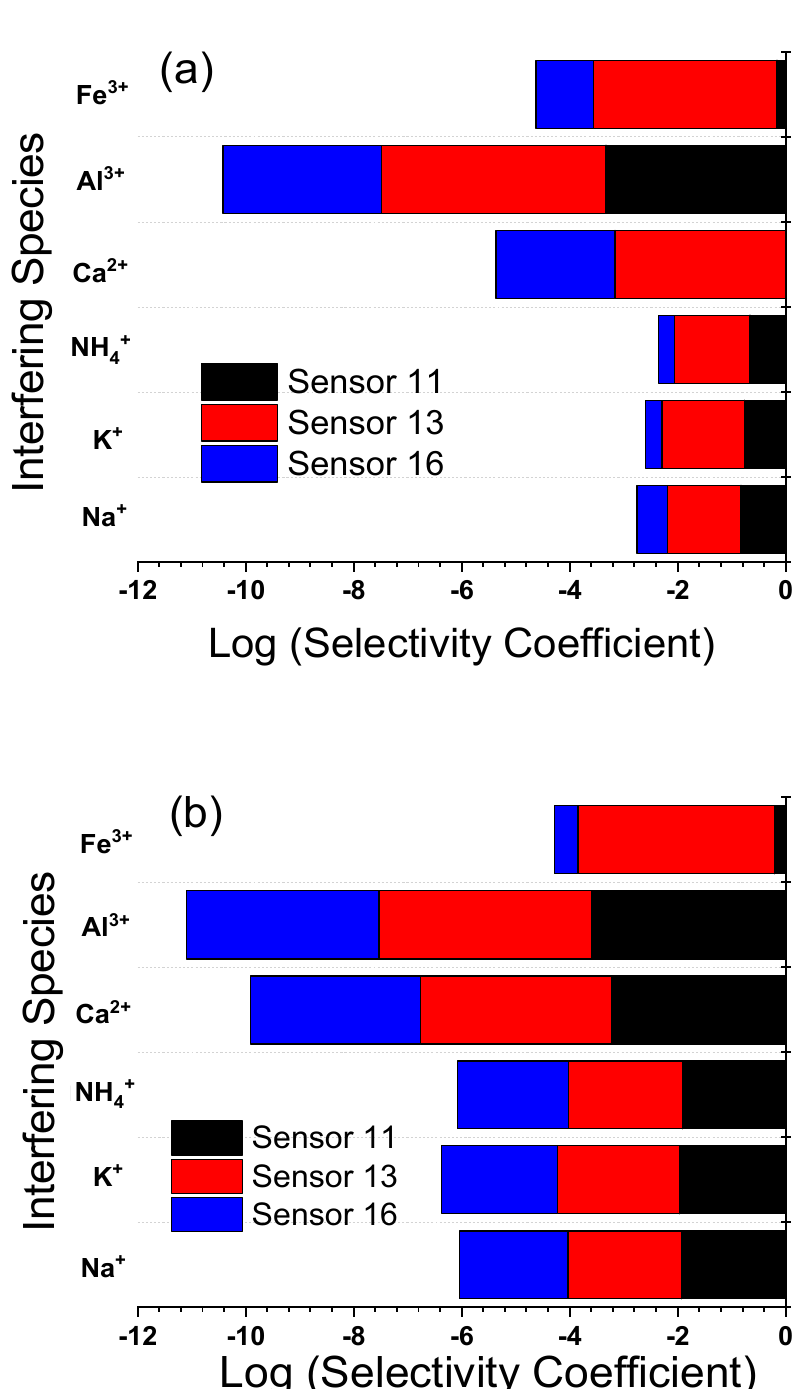
. Figure 9. Log selectivity coefficient, log K pot. , determined by using SSM and MPM for a carbon LF 2 + ,J + z paste electrode (CPE, sensor 11); PVC membrane coated on a carbon paste electrode (C-CPE, sensor 13); PVC/CD plasticized carbon paste electrode (P-CPE, sensor 16) at room temperature of 22 ± 2 ◦ C: ( a ) at pH 2.2; ( b ) at pH 4.1. The electrode compositions (%, wt / wt ) are given in (Table